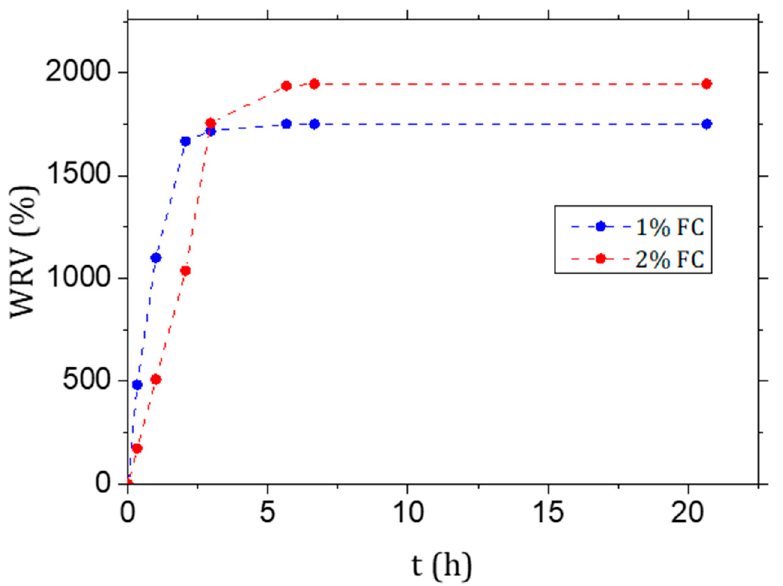
Figure 6. Water retention value (WRV%) of the fibrillated cellulose (FC) gel used to cast the samples diluted to 1% and 2% w / w .